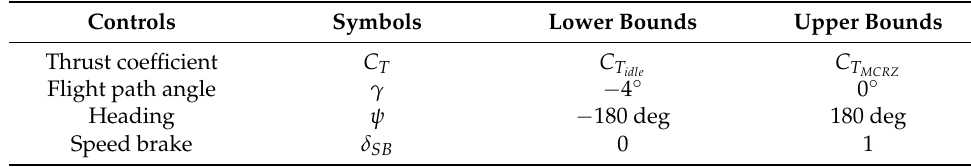
Table 4. Limitations for the control inputs across the